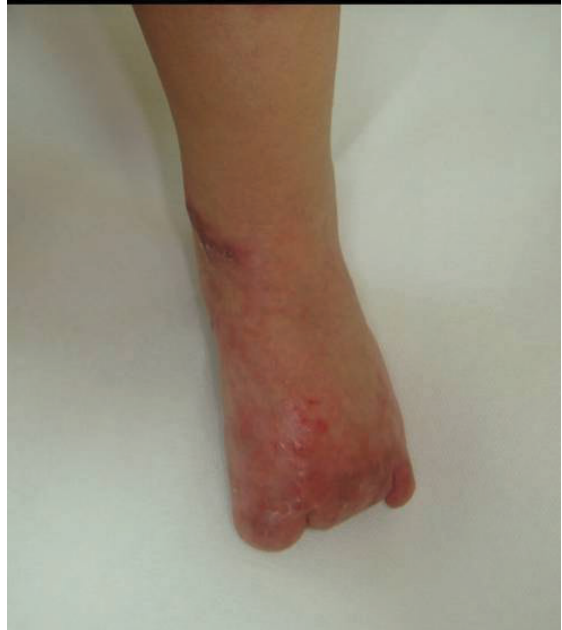
Figure 2. Mild discoloration of the dorsal foot after healing of the lesions and toe